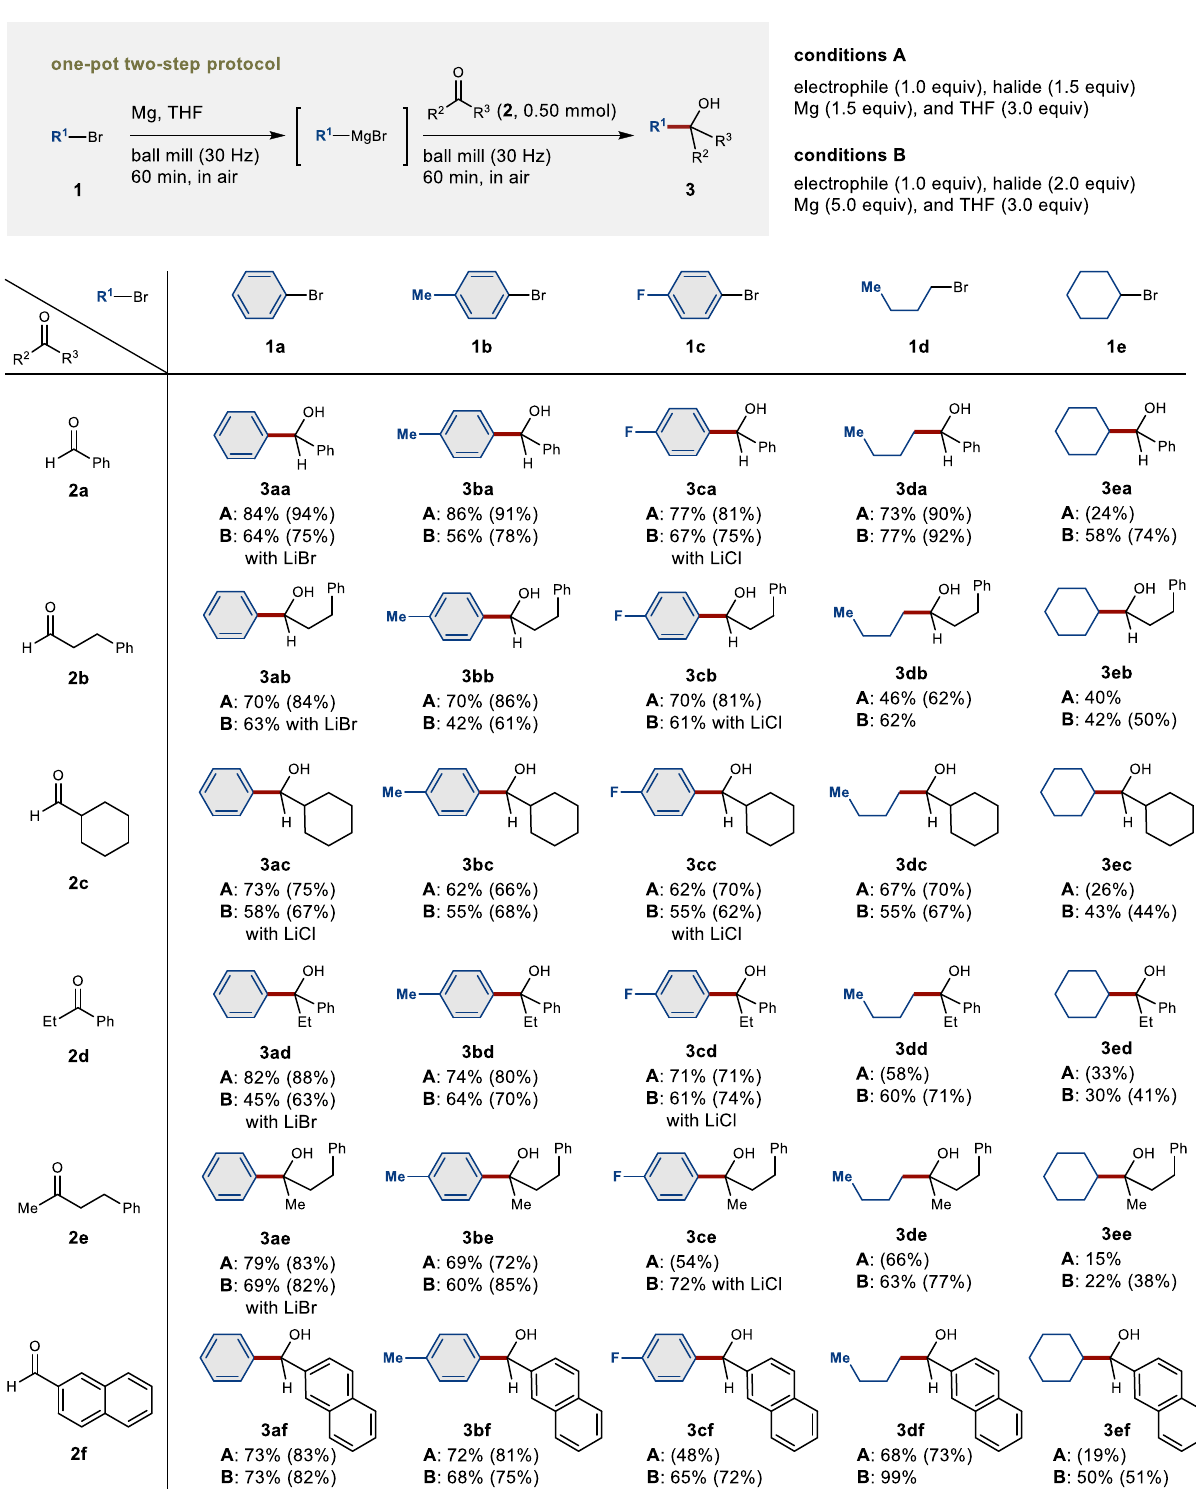
Fig. 2 Scope of the mechanochemical synthesis of organomagnesium nucleophiles and their nucleophilic addition to aldehydes and ketones in a ball mill. A stainless-steel milling jar (5 mL) and stainless-steel ball (diameter: 10 mm) were used. Isolated yields are reported as percentages. Proton NMR integrated yields are shown in parentheses. For details, see the Supplementary